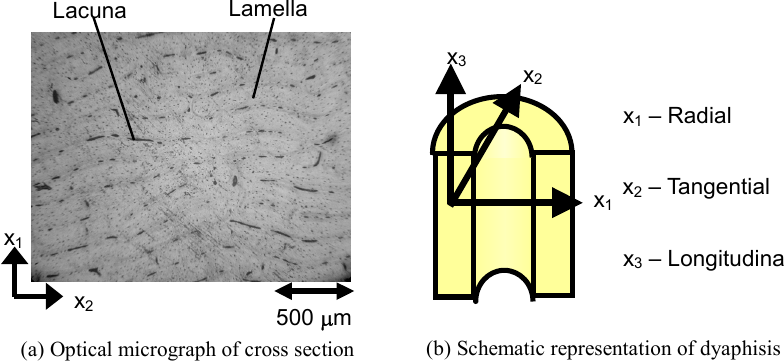
Fig. 1. Cross section of bovine cortical bone (Plexiform bone) and geometry of